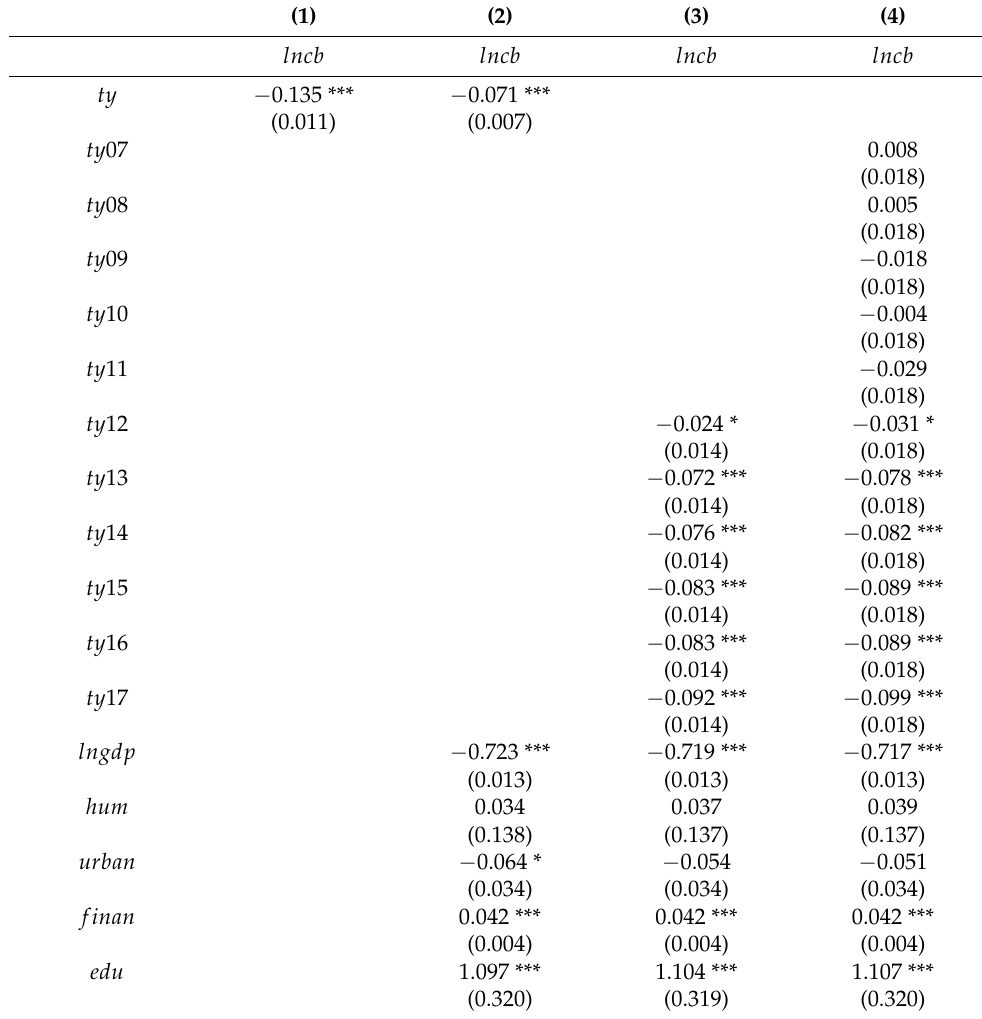
Table 2. The impact of STFP on carbon